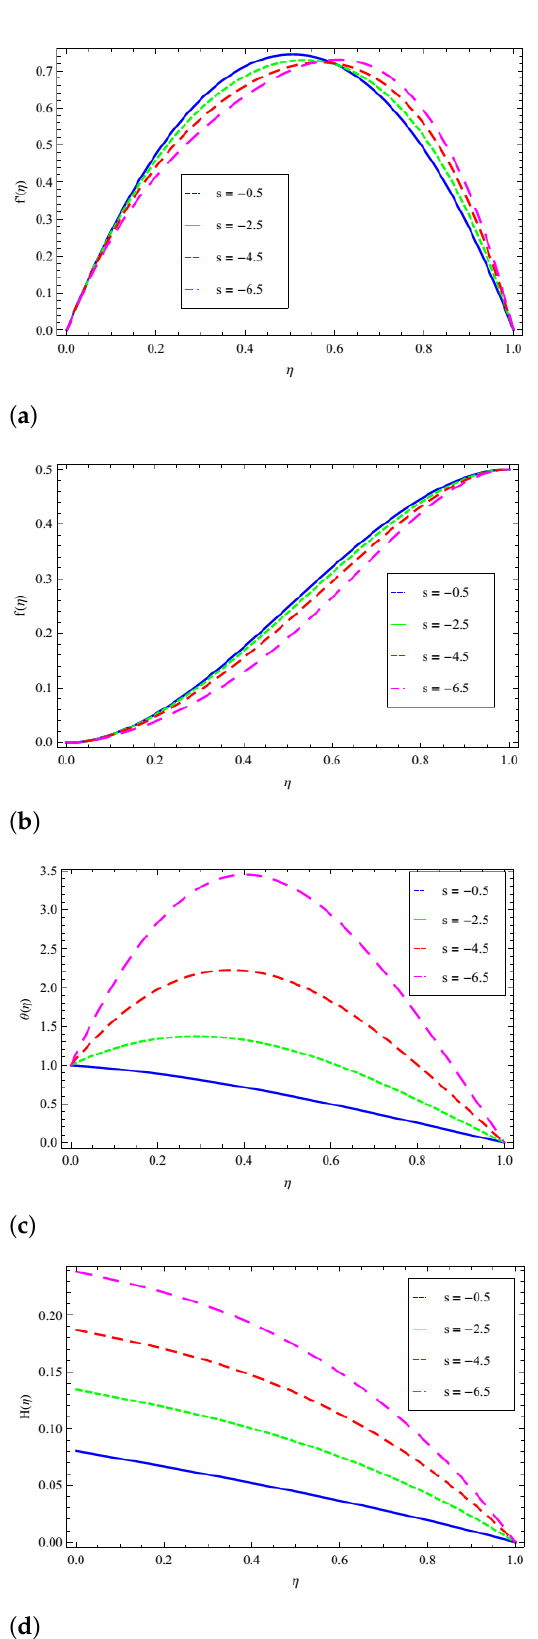
Figure 3. Impact of S on ( a ) velocity component along y-axis f (cid:48) ( η ) , ( b ) velocity component along x-axis f ( η ) , ( c ) heat distribution variable θ ( η ) and ( d ) homogeneous reaction H ( η ) for the specific values P r = 0.1, Ha = 1, R = 0.05, L = 0.01, K 1 = K 2 = Sc = 0.5, Q = 10, δ =